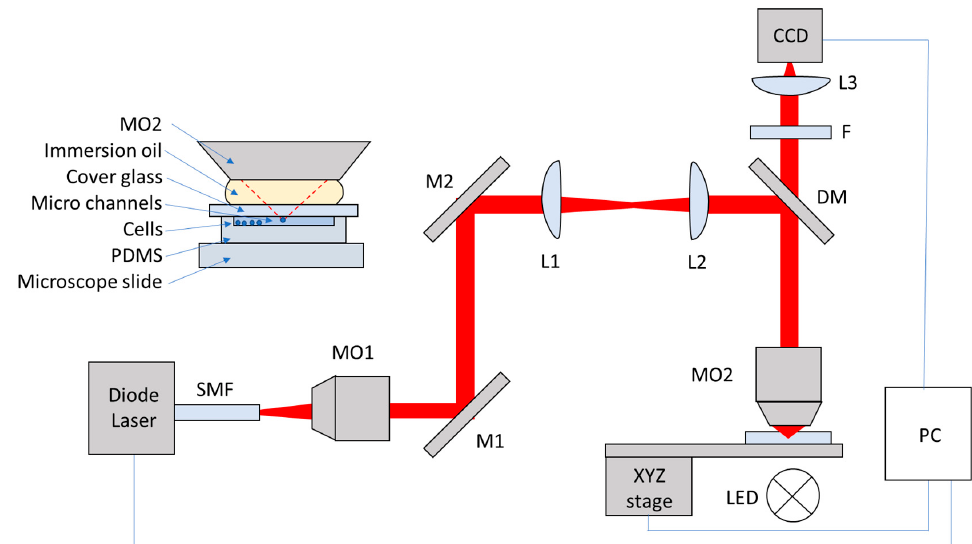
Figure 1. Optical tweezers. The beam emitted from the laser via a single mode fiber (SMF) is collimated by a 10× microscope lens (MO1). The two mirrors, M1 and M2, direct the laser light into an image relay system (L2 and L3). The laser light is reflected using a dichroic mirror (DM) into a ×100, 1.3 NA immersion objective lens (MO2). Inset is a sample which is placed on the sample stage.